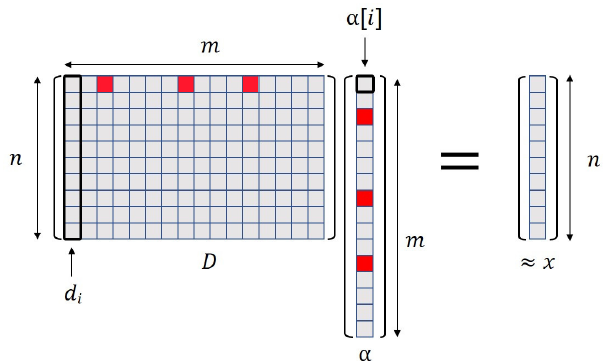
Figure 7. Reconstruction (synthesis) process of a signal x using its sparse representation α and a dictionary D . Coefficients in α are related to the atoms or elemental signals in D ; therefore, an approximation of the original signal ≈ x can be